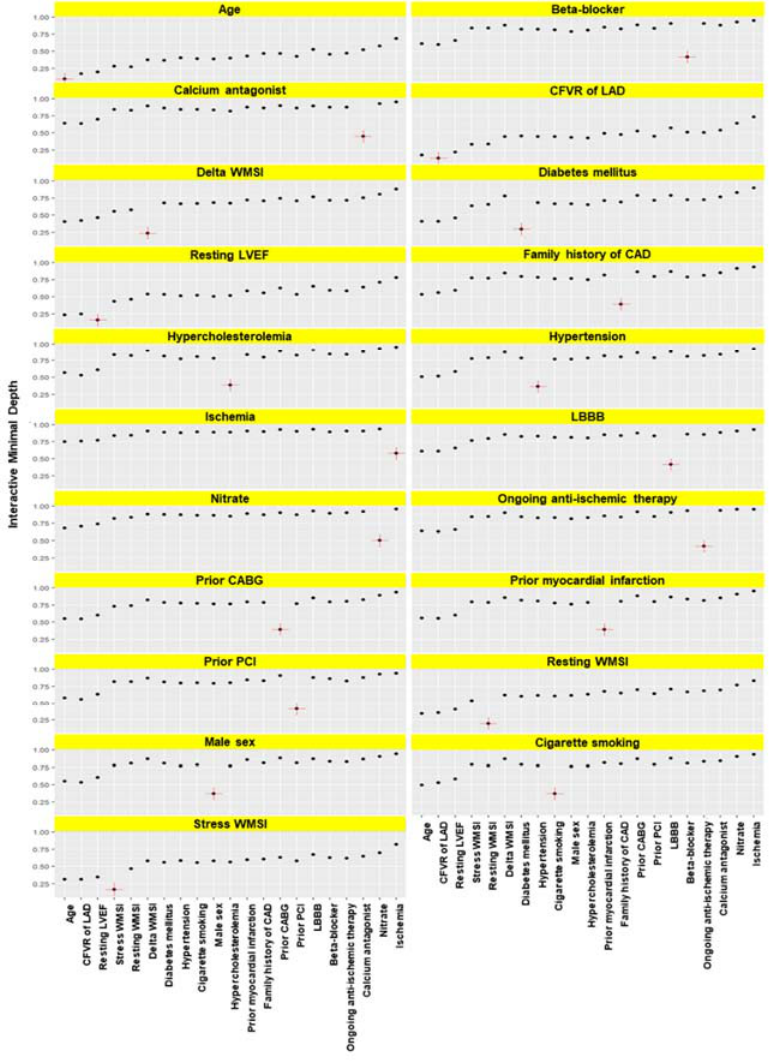
Figure 4. Minimal depth variable interactions. Reference variables are marked in red within each panel. Higher values indicate a lower reference variable.